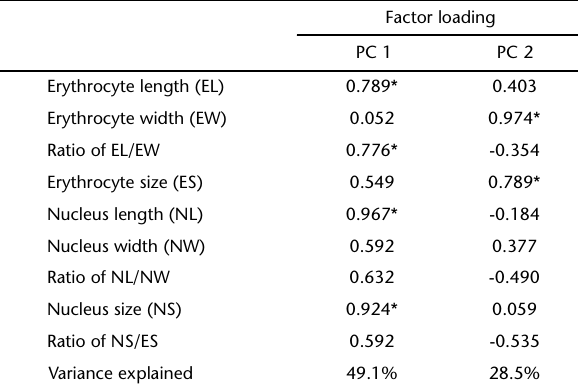
Table 2. Loading of the first two axes of a principal component analysis on nine variables of erythrocyte